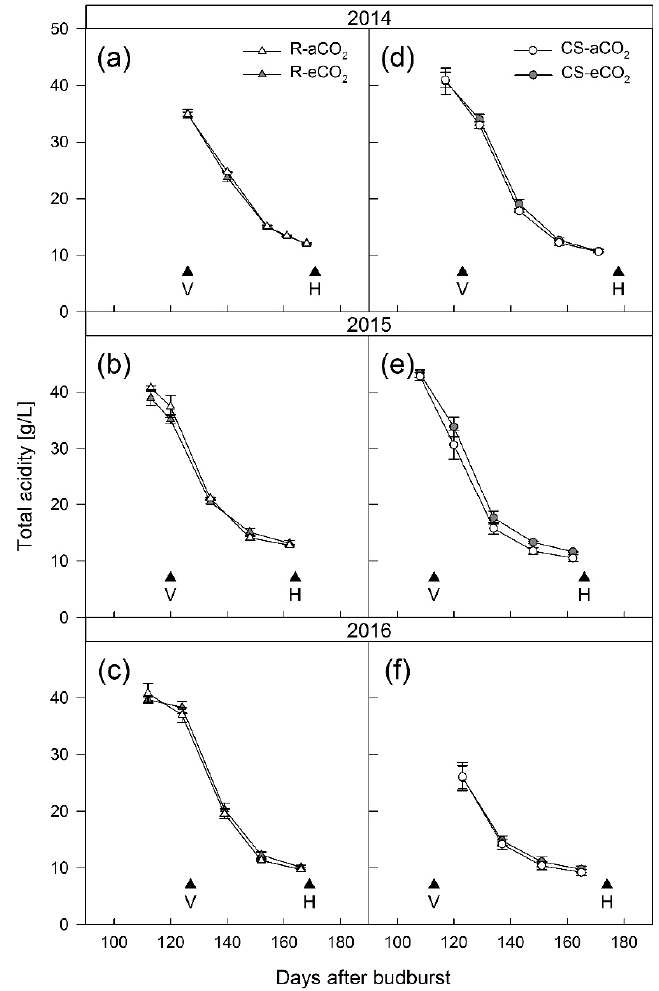
Figure 6. Total acidity degradation during berry ripening in 2014, 2015, and 2016 for Riesling ( a – c ) and Cabernet Sauvignon ( d – f ) and the two treatments aCO 2 and eCO 2 . Letters indicate seasonal development stages veraison (V) and harvest (H). Total acidity is expressed as tartaric acid in g / L. Mean values per treatment ± SD of the three FACE